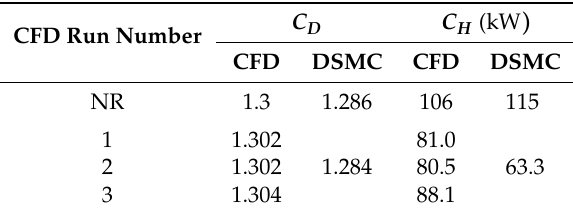
Table 5. Aerothermodynamic